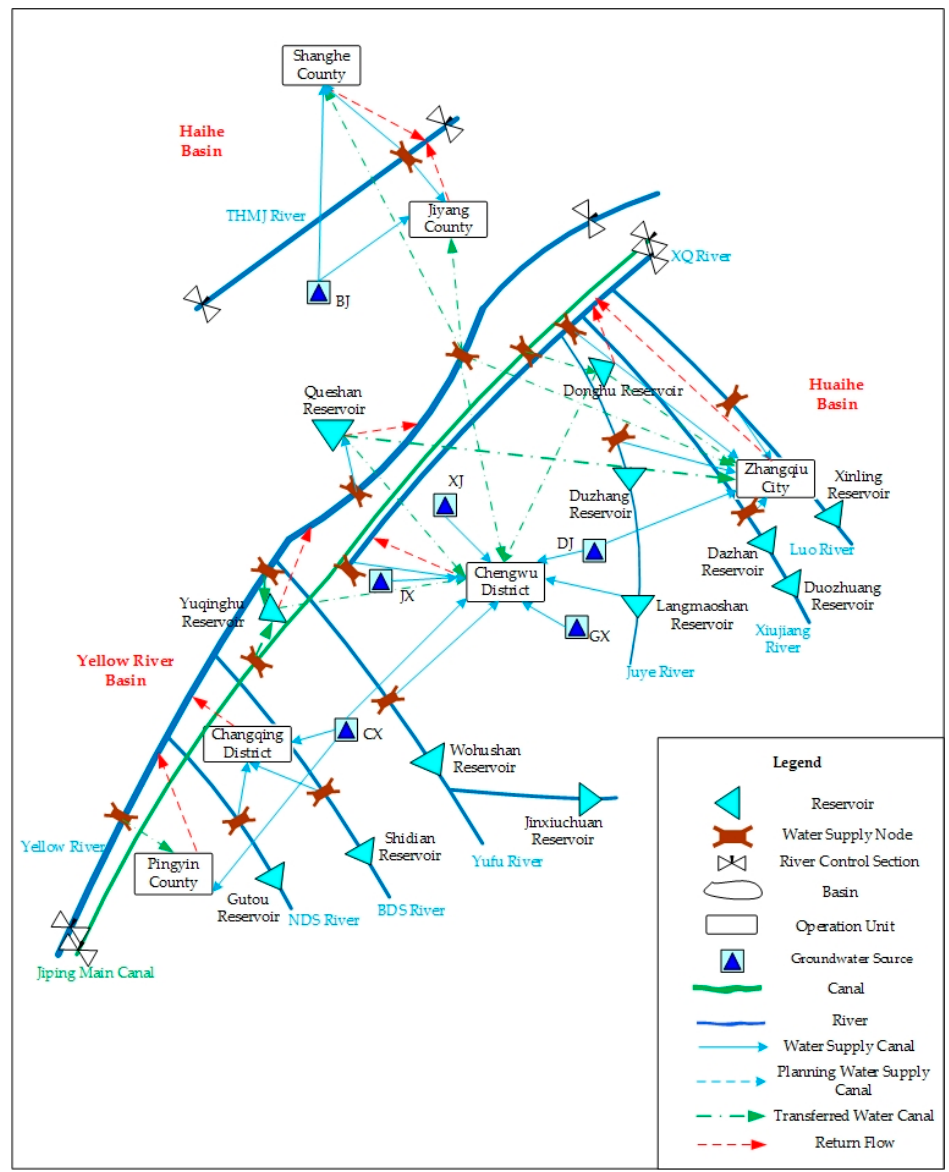
Figure 3. Water resource deployment network chart of Jinan.